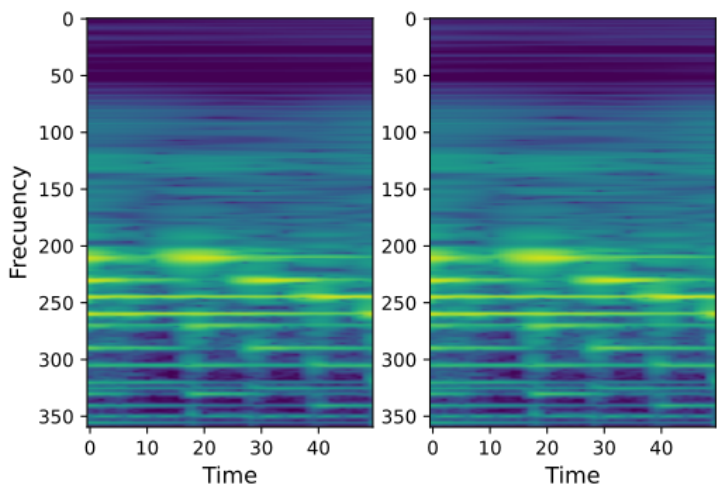
Figure 4. Constant-Q transform (CQT) calculated with our method with a margin of 64 × 512 samples ( left ), CQT slice clipped from the full CQT ( right ) of a Slakh2100 piano track. The horizontal axis of the CQT slices in the figure have been rescaled for a better visualization.